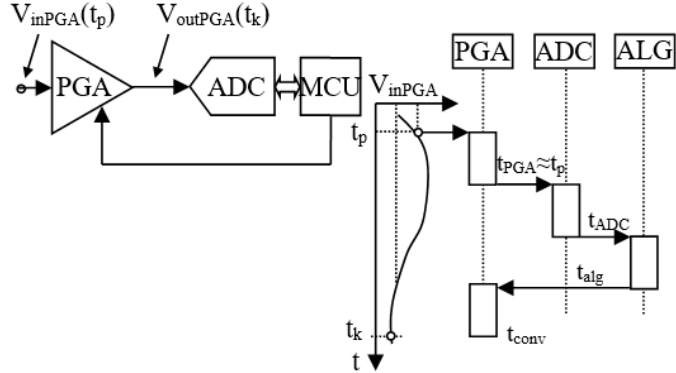
Figure 1. Signal processing in the structure of an AGC based on PGA amplifiers.